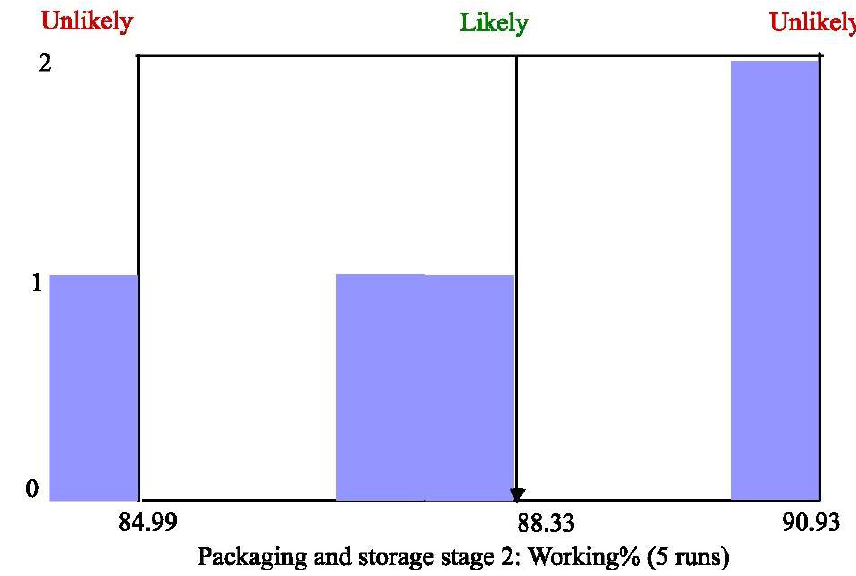
Figure 9. MORE plot for working% in packaging and storage in stage 2.